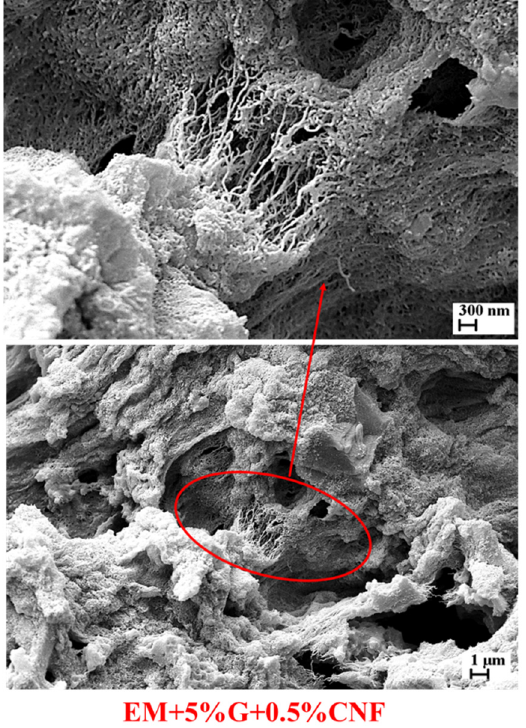
Figure 9. SEM images at different magnifications of the EM + 5%G + 0.5%CNF sample. The multifunctional nanocomposite EM + 5%G + 0.5%CNF was subjected to morpho- logical analysis by tunneling atomic force microscopy (TUNA-AFM) in order to evaluate